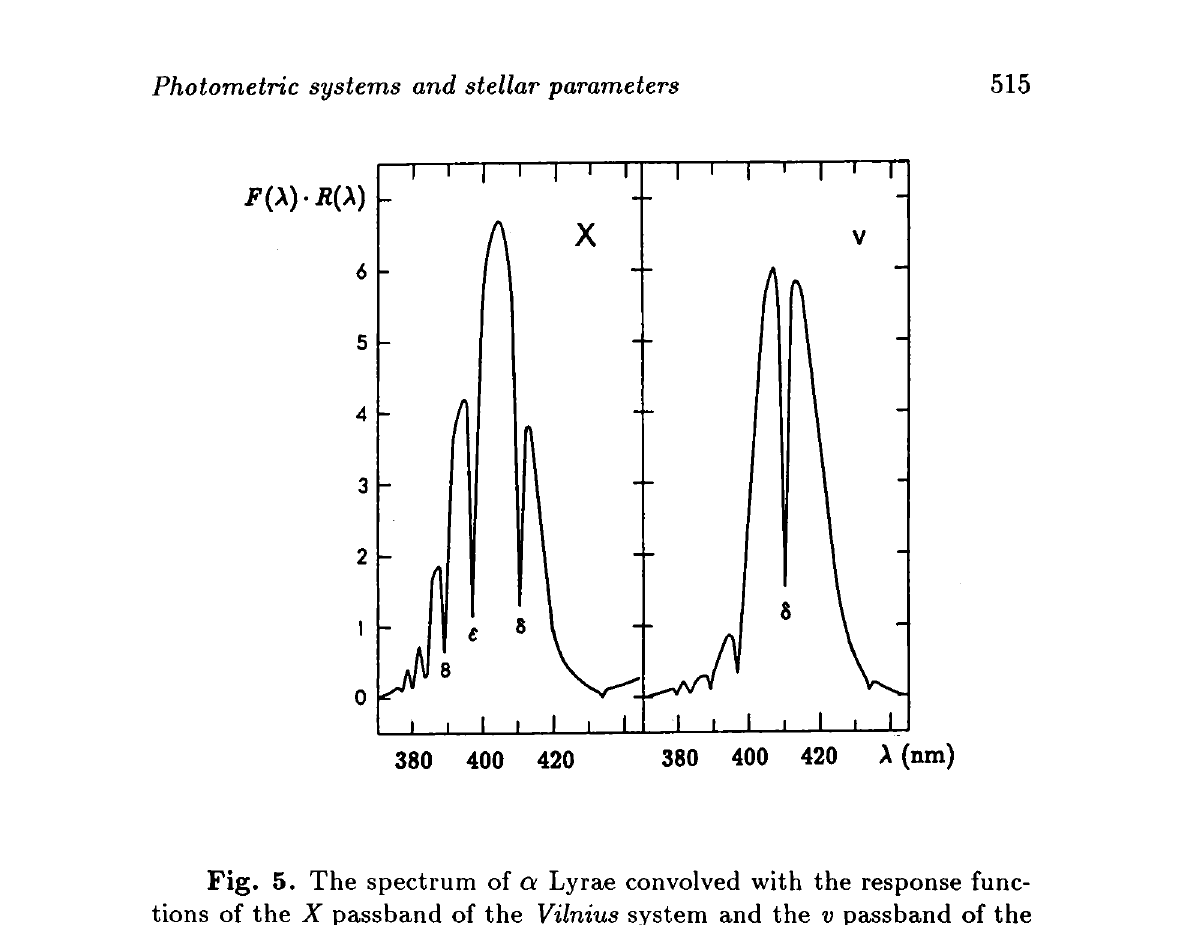
Fig. 5. The spectrum of a: Lyrae convolved with the response func- tions of the X passband of the Vilnius system and the v passband of the Stromgren system. The Balmer lines Hi, He and H8 are seen. the strongest ozone absorption bands. It almost coincides with the u passband of the Stromgren uvby